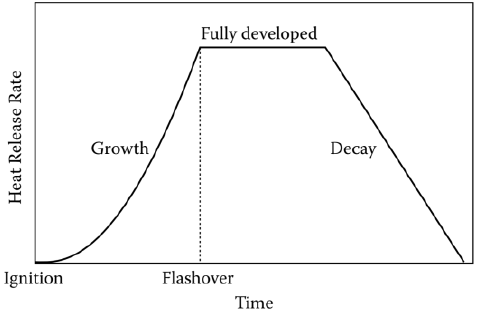
Figure 1. Four phases of a fire curve.